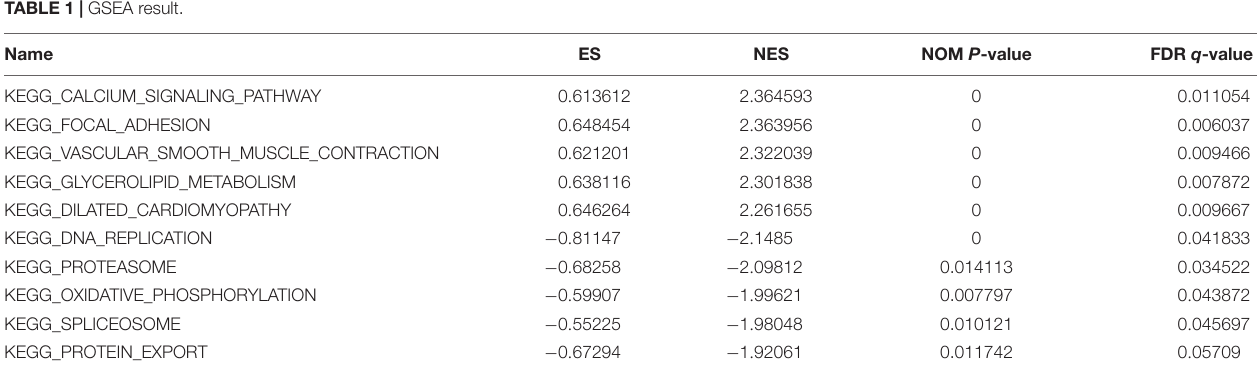
FIGURE 9 | The relationship between PPARG and tumor mutation burden. (A) Overview of TCGA-BRCA cohort mutations. (B) Waterfall of the top 20 mutated genes in the TCGA-BRCA cohort. (C) The correlation between 20 genes. (D) The clinical correlation analysis. (E) Correlation analysis of TMB and prognosis. (F) Correlation analysis between PPARG and TMB. (G) Comparison of TMB levels in high- and low- PPARG groups. TABLE 1 | GSEA